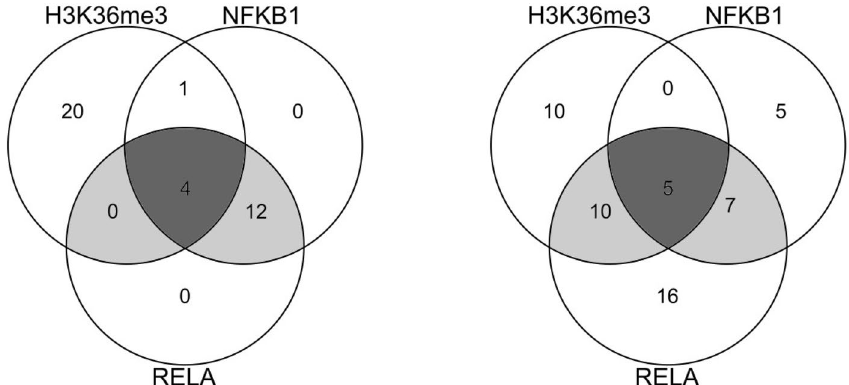
Figure 4. Venn diagrams of the enrichment of TF-binding sites and histone modifications for the 123 genes, as identified by Enrichr. The numbers in each diagram indicate the numbers of genes selected by PCAUFE and regulated by the TFs. Left: NFKB1, RELA (TRRUST Transcription Factors 2019), and H3K36me3_ GM06990_hg19 (ENCODE Histone Modifications 2015); right: NFKB1 (TRRUST Transcription Factors 2019),